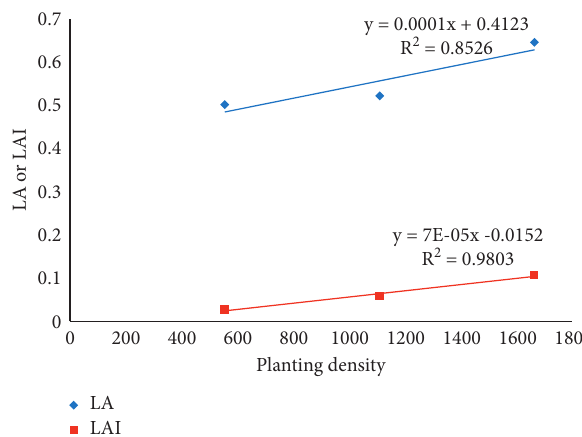
y = 0.0001x + 0.4123 R 2 = 0.8526